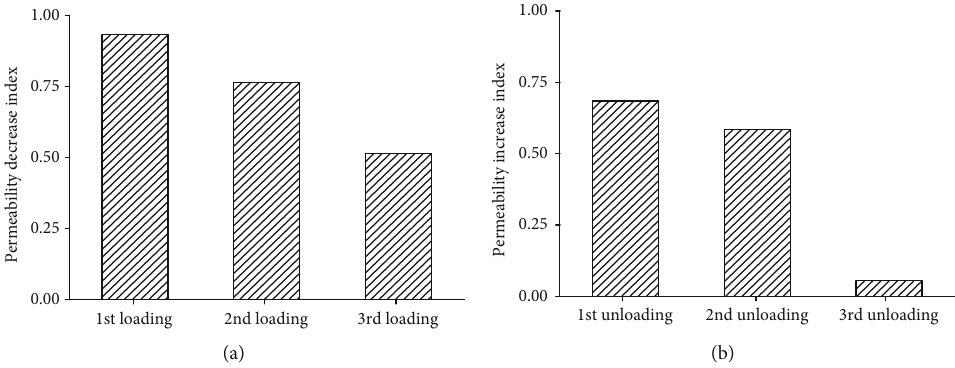
Figure 8: Permeability variation index for fractured sandstone specimens in all cycles of con fi ning